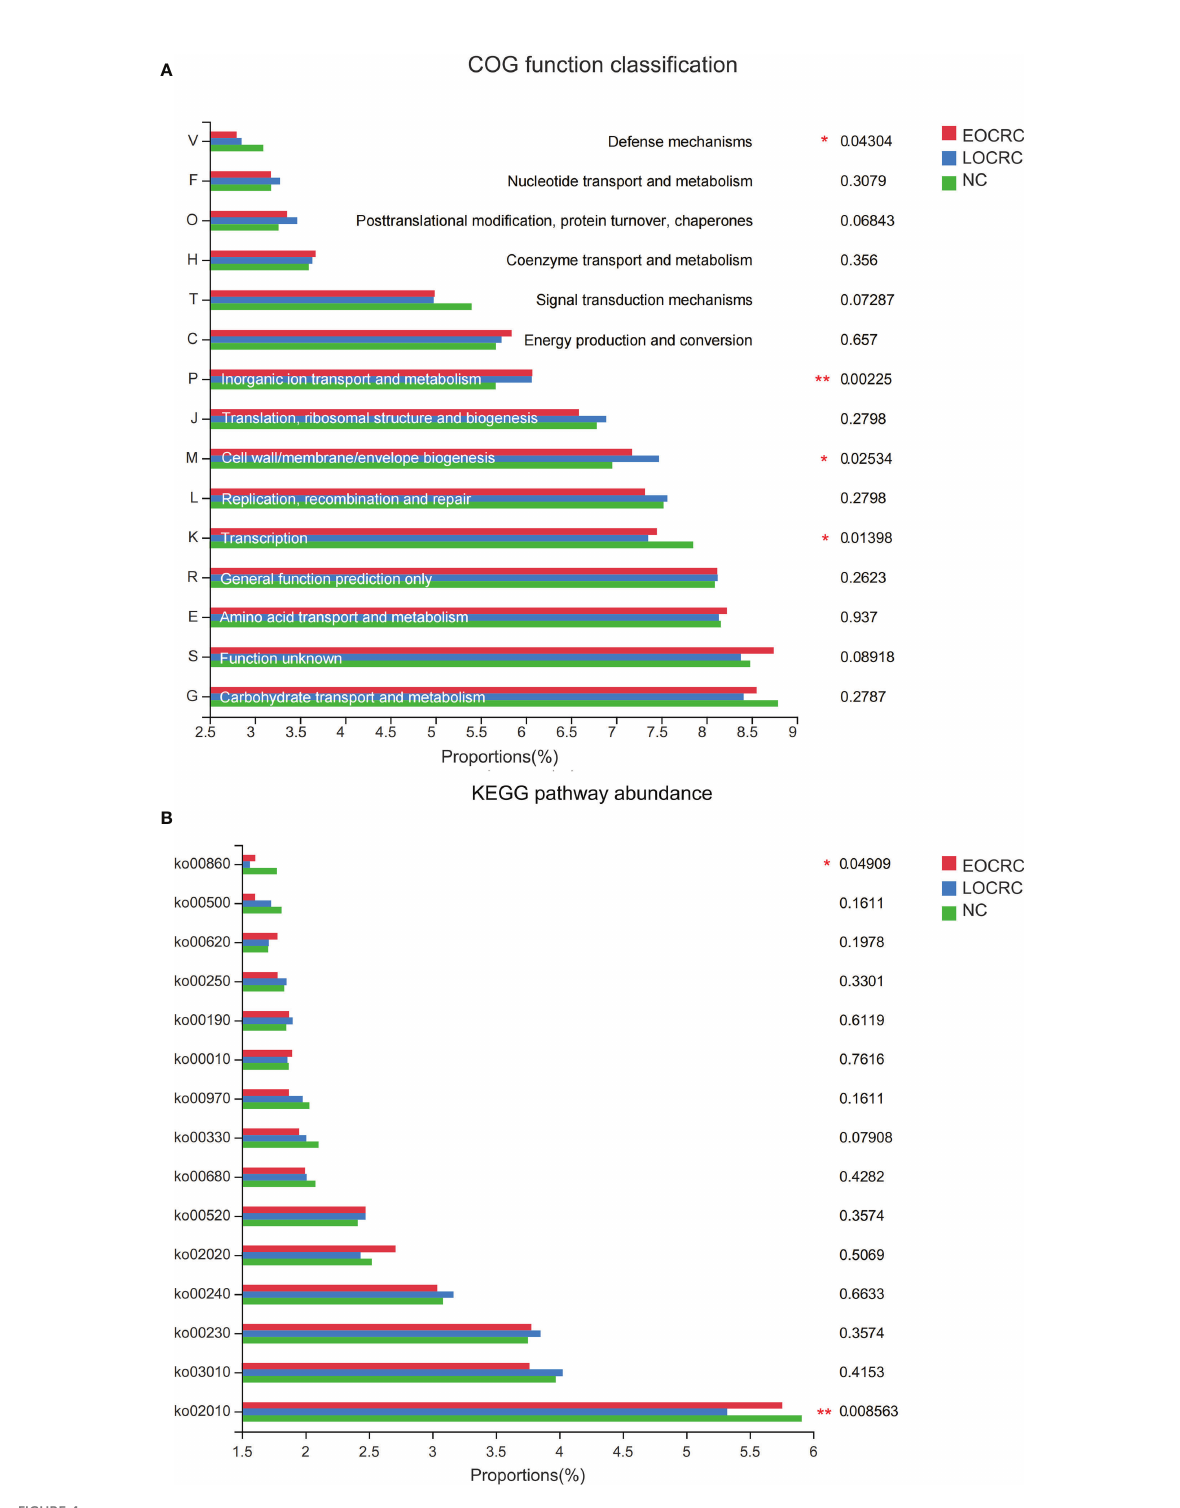
FIGURE 4 The function prediction of the three groups. A : The differences of Cluster of Ortholog Genes (COG) function. B : The abundance differences of the Kyoto Encyclopedia of Genes and Genomes (KEGG) pathway. 0.01 < corrected P-value ≤ 0.05 marked as *; 0.001 < corrected P-value ≤ 0.01 marked as